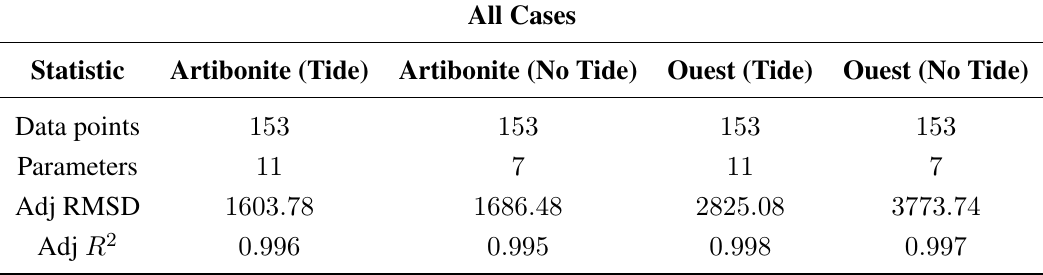
Table 3. Model predictions versus data statistics for the cumulative number of cases: root mean squared deviations (RMSD), coefficient of determination ( R 2 ) . Degrees of freedom for the statistics are adjusted by the number of parameters fit in the calibration process. All Cases